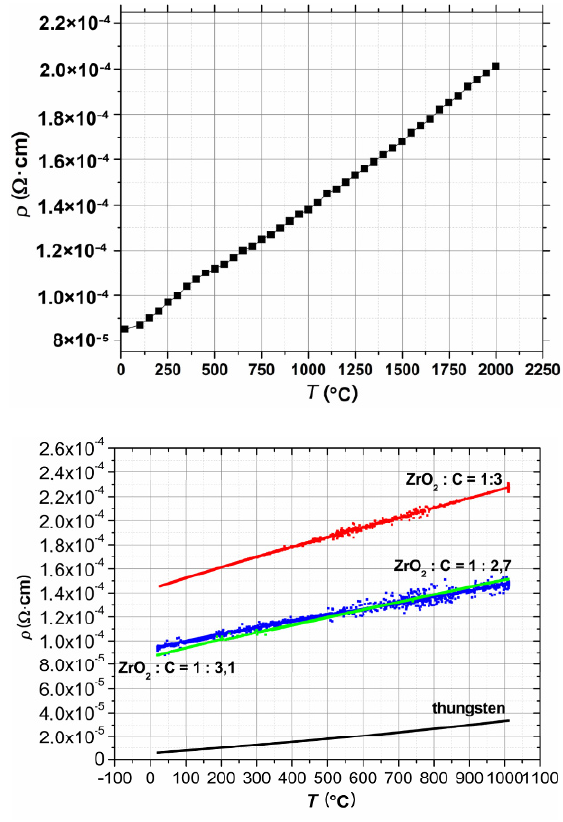
Fig. 11 Electrical resistivity of ZC 1-2.8 sintered at 2000 ℃ in dependence of temperature up to 1000 ℃ (bottom) and 2000 ℃